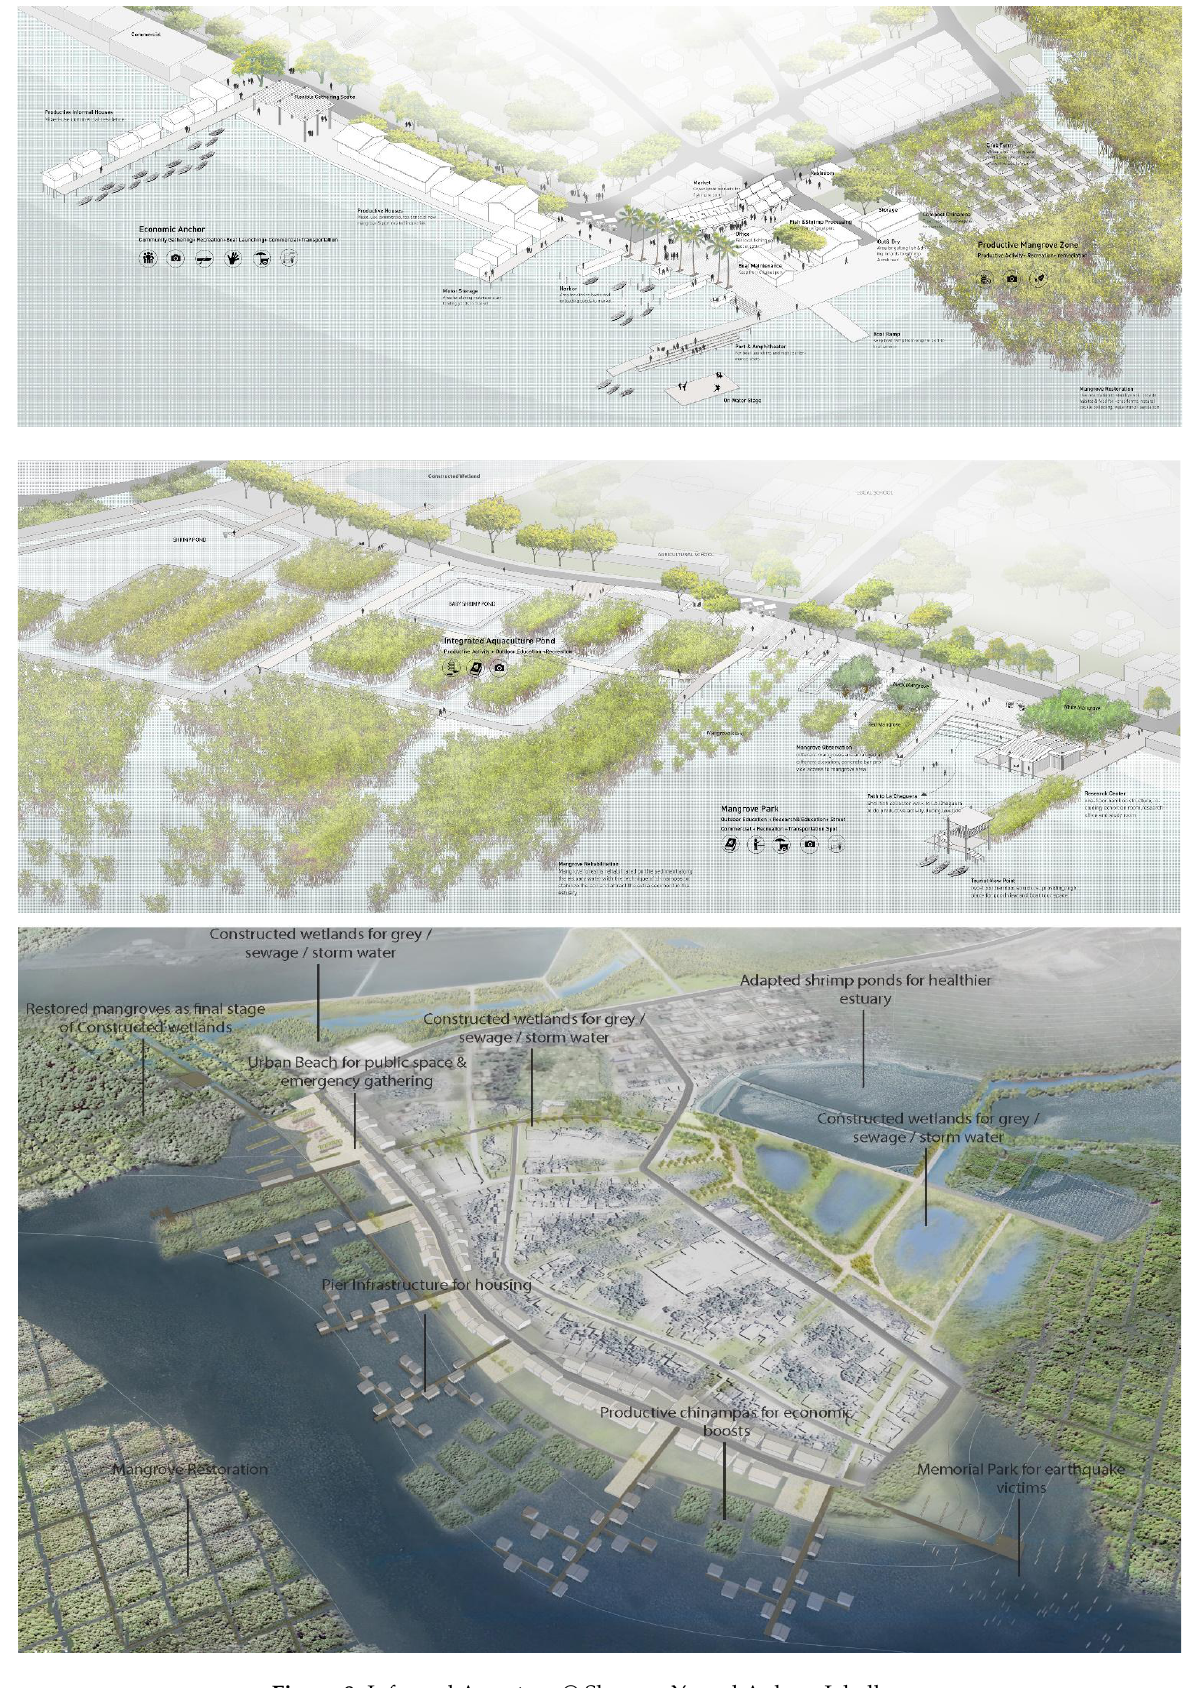
Figure 8. Informal Armature © Shuwen Ye and Aubrey Jahelka.